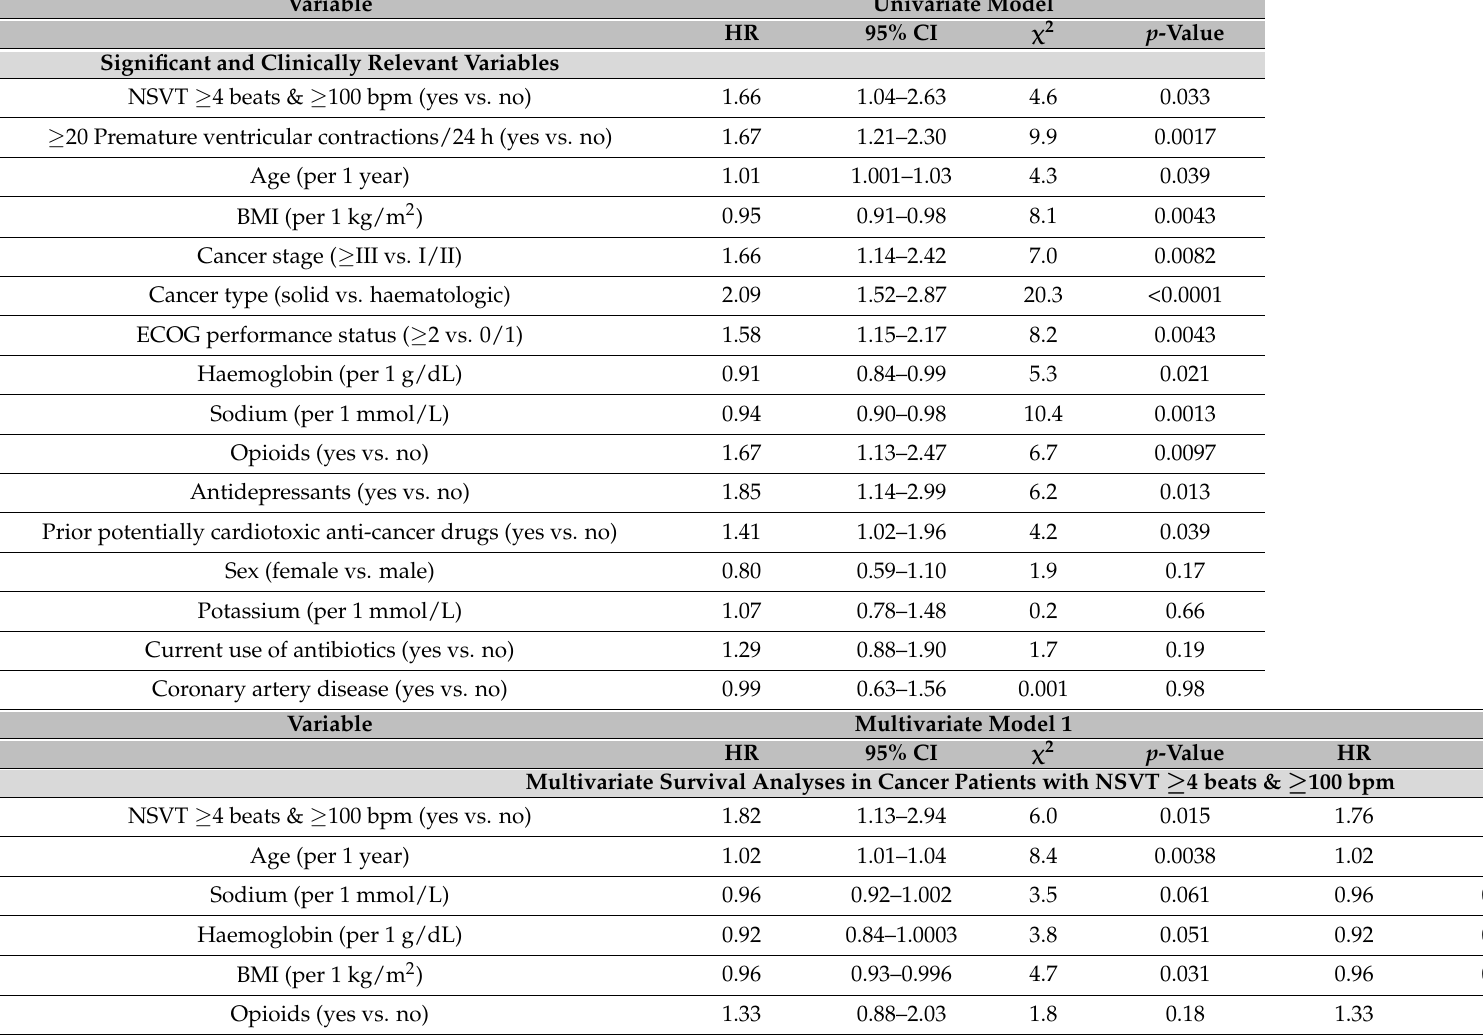
Table 2. Univariate and Multivariate survival analyses in cancer patients ( n =